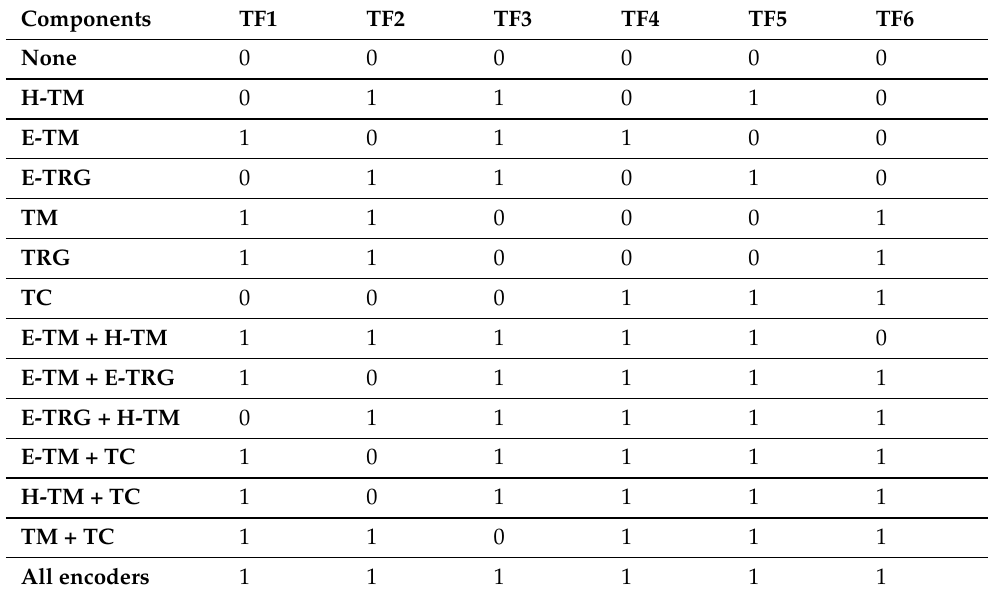
Table 3. Flag-failure associations for all the